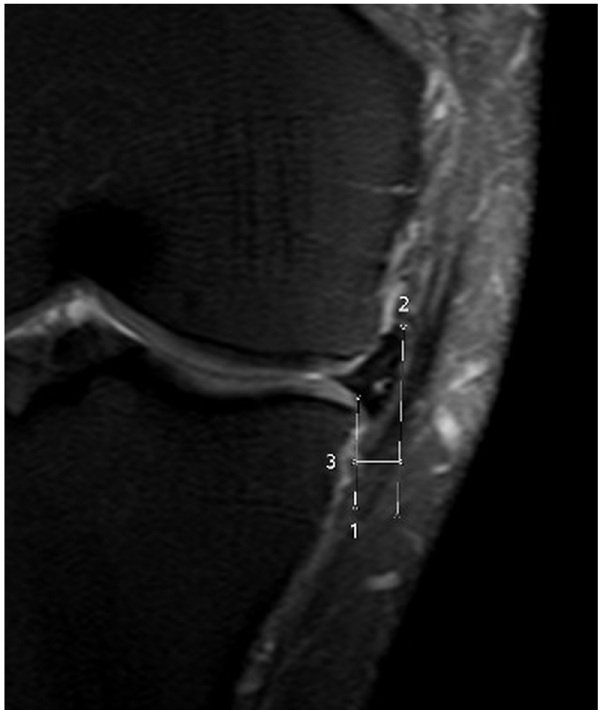
Fig 1. Meniscal extrusion is defined as the greatest distance (line No 3) from the most peripheral aspect of the meniscus (line No 2) to the border of the tibial plateau (line No